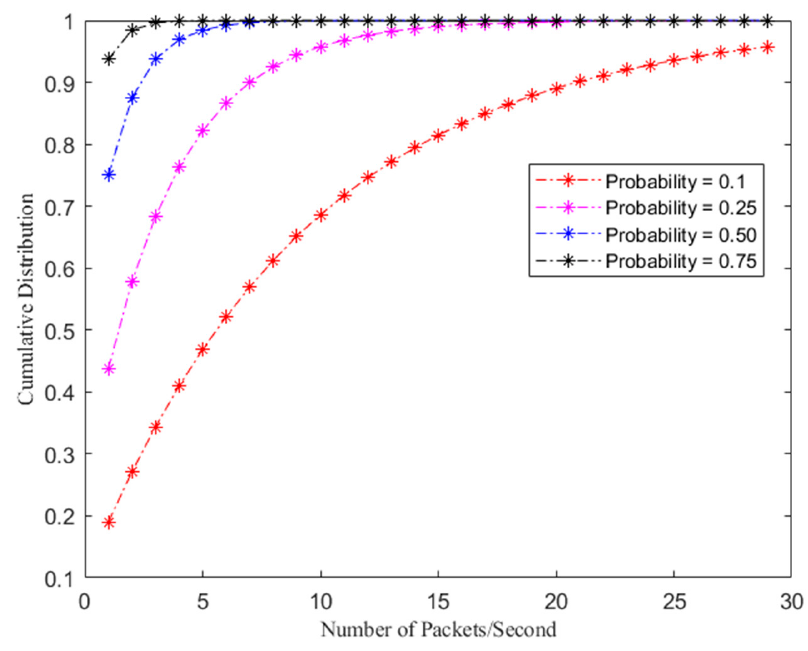
Figure 10. Cumulative distribution with probability 0.1, 0.25, 0.50, and 0.75.